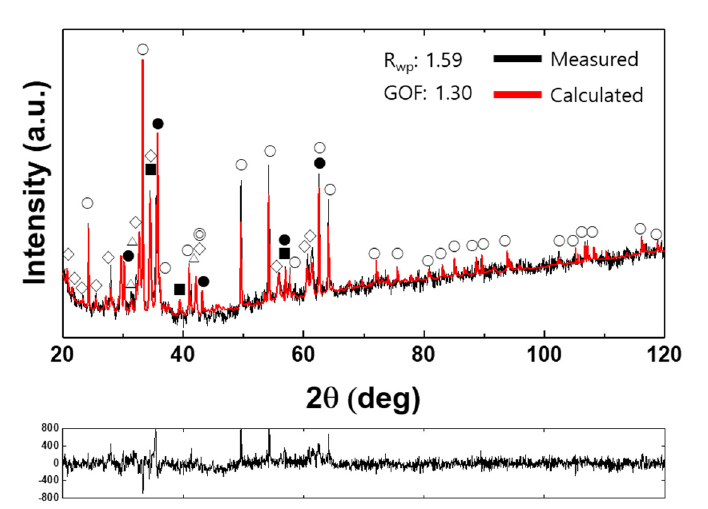
Figure 5. Examples of an XRD pattern and a Rietveld analysis result for a synthetic iron ore sinter (Sample #6 in Table 5; ○ : Fe 2 O 3 ; ● : Fe 3 O 4 ; ◇ : SFCA; △ : C2S; ◎ : FeO; ■ : Al 2 O 3 ) [50].